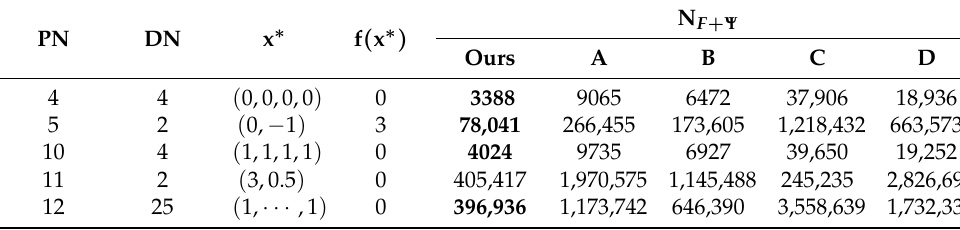
Table 5. Numerical comparison results of Problems 4, 5, and